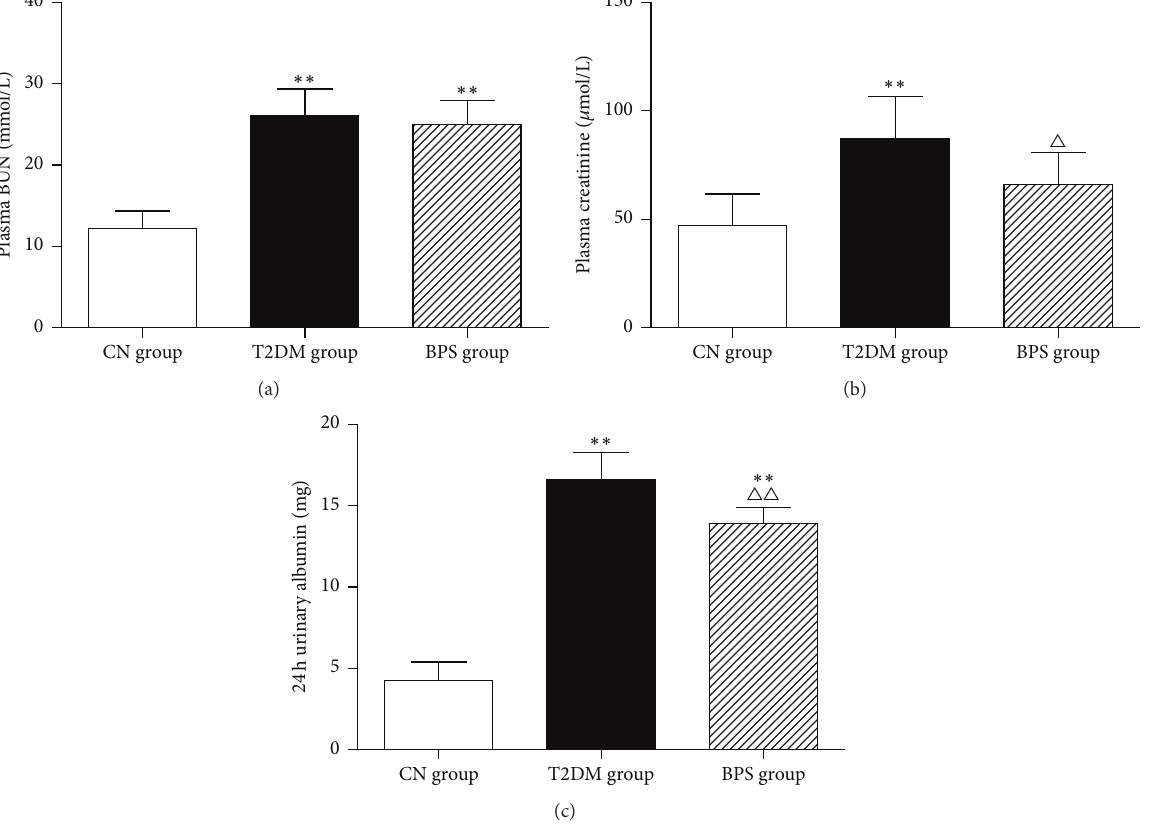
Figure 2: Plasma BUN (a), plasma creatinine (b), and 24h urinary albumin (c) in CN group rats, T2DM group rats, and BPS group rats. As bar graph, data are mean ± SEM of 6 rats. ∗ 𝑃 < 0.05 and ∗∗ 𝑃 < 0.01 T2DM group and BPS group versus CN group rats and 󳵻 𝑃 < 0.05 and 󳵻󳵻 𝑃 < 0.01 BPS group versus T2DM